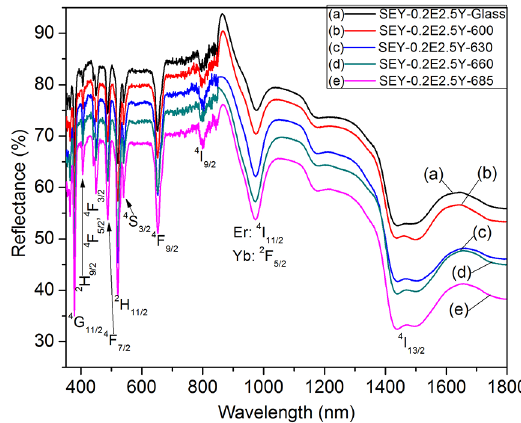
Figure 4. Reflectance spectra of Er 3+ /Yb 3+ co-doped in SEY-0.2E2.5Y- glass, SEY-0.2E2.5Y-600, SEY-0.2E2.5Y-630, SEY-0.2E2.5Y-660, and SEY-0.2E2.5Y-685 transparent glass-ceramics samples.